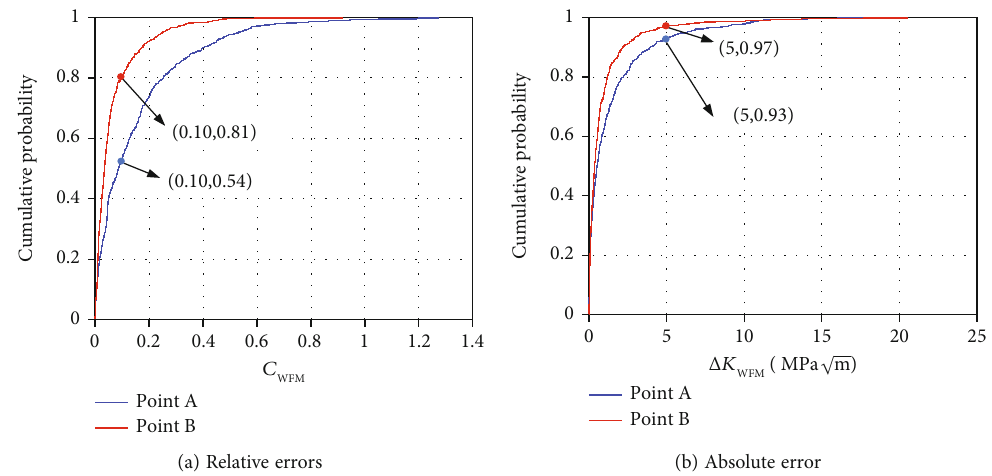
Figure 8: The errors of SIFs calculated by weight function method and fi nite element method.